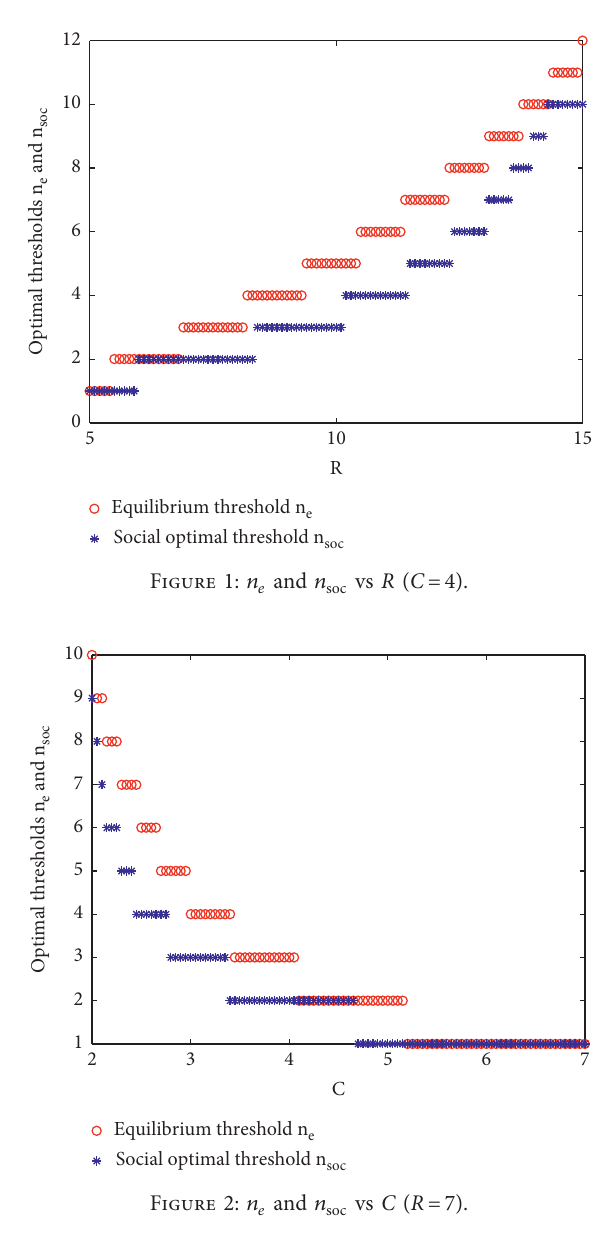
n vs C ( R � e and soc